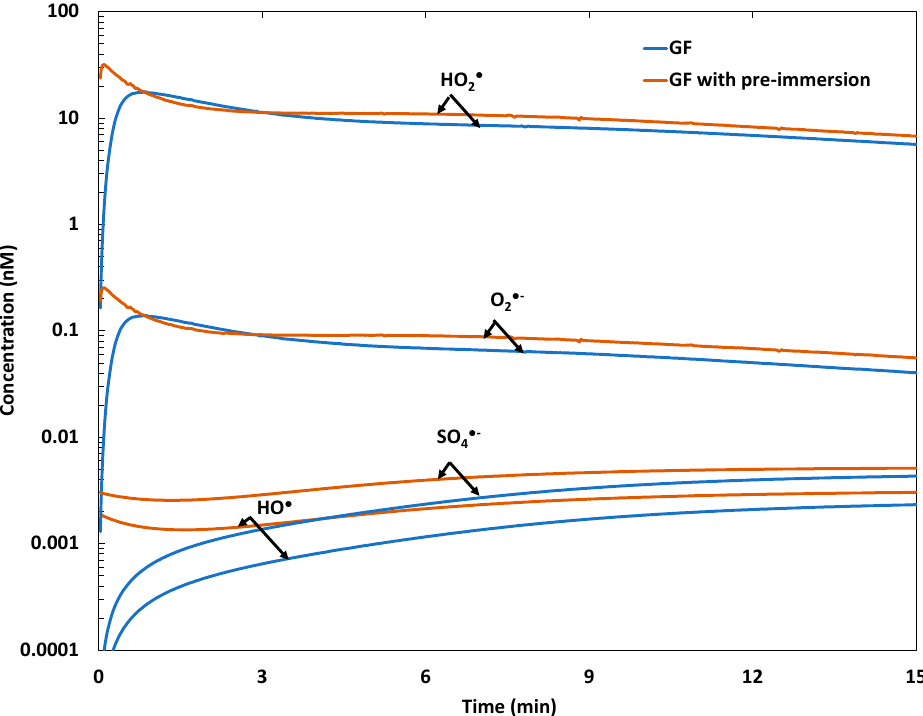
Figure 6. Comparison of the Galvano-Fenton and the Galvano Fenton with pre-immersion in terms of the concentrations of free radicals.